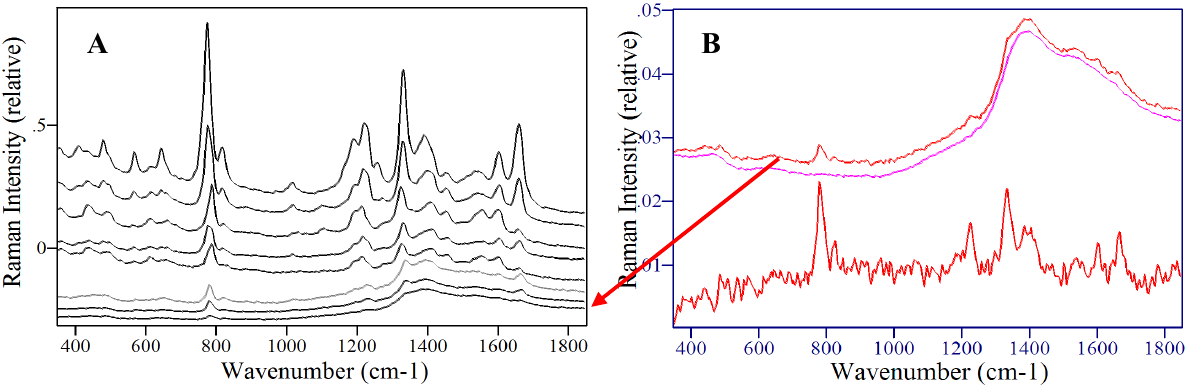
Figure 9. SER spectra of 5-FU at A) 500, 100, 10, 5, 1, 0.5, 0.1, 0.01 μ g/mL (top to bottom) and B) 10 ng/mL 5-FU before (top) and after (bottom) subtraction of glass capillary background spectrum (middle). Conditions: silver-doped sol-gels in capillaries, 100 mW of 785 nm,